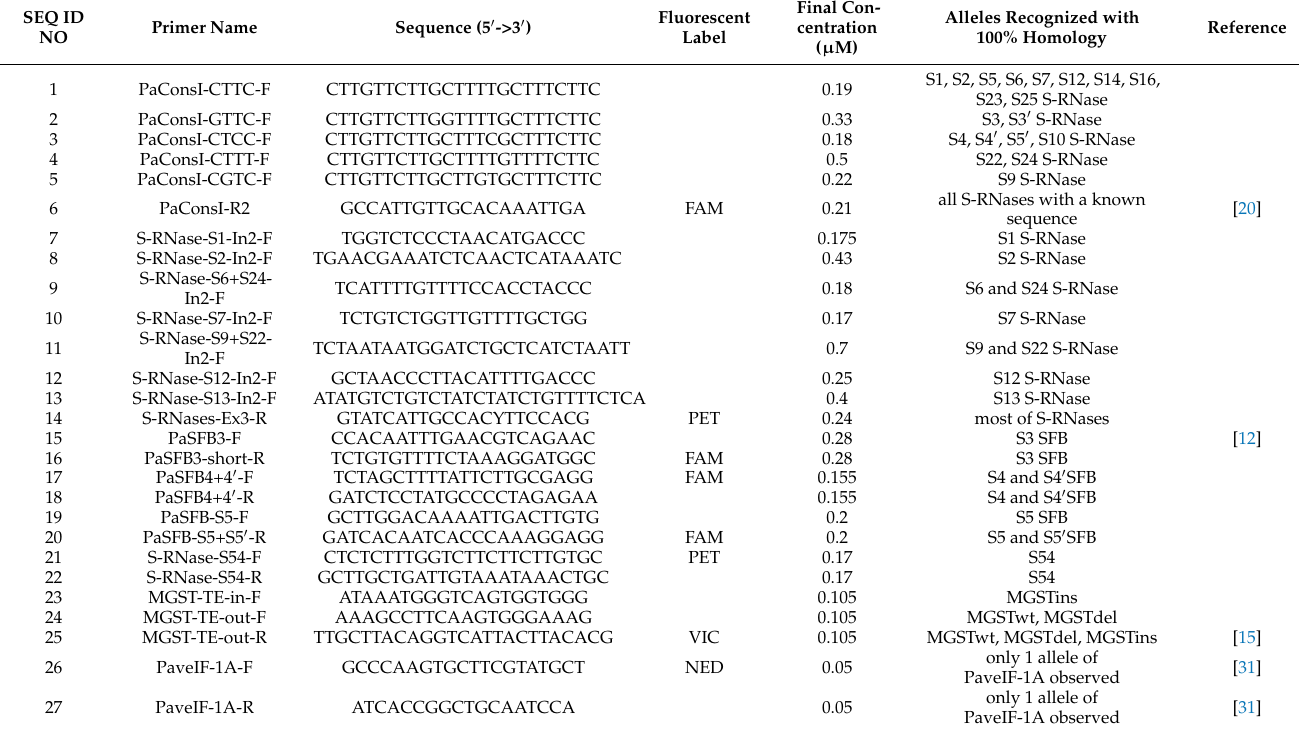
Table 1. Overview of primers used in the study. MGSTins denotes the allele with an insertion in the MGST promotor described by Ono et al. [15]. MGSTwt stands for the wild-type sequence, and MGSTdel for the 8 nt deletion identified in this study (see Supplementary Figure S4). Rows with an empty reference cell refer to this